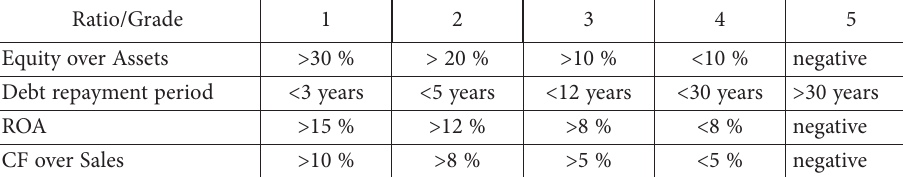
Table 4. Kralicek Quick Test evaluation table (source: authors based on Kralicek, 2007) Ratio/Grade 1 2 3 4 5 Equity over Assets